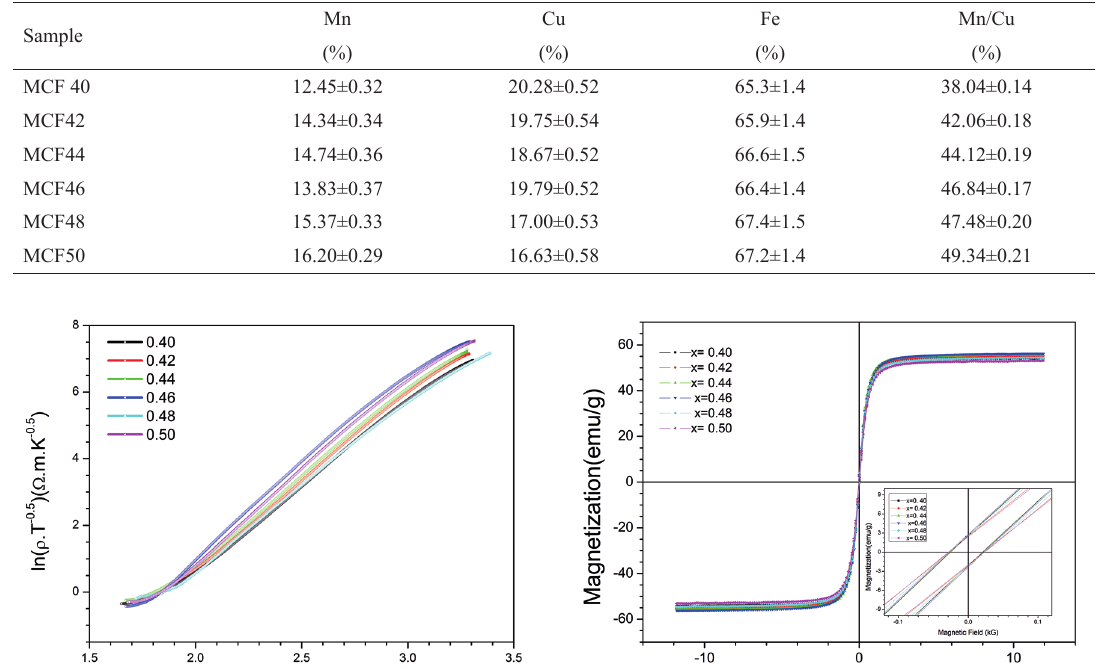
Cu Fe O . x 1-x 2 4